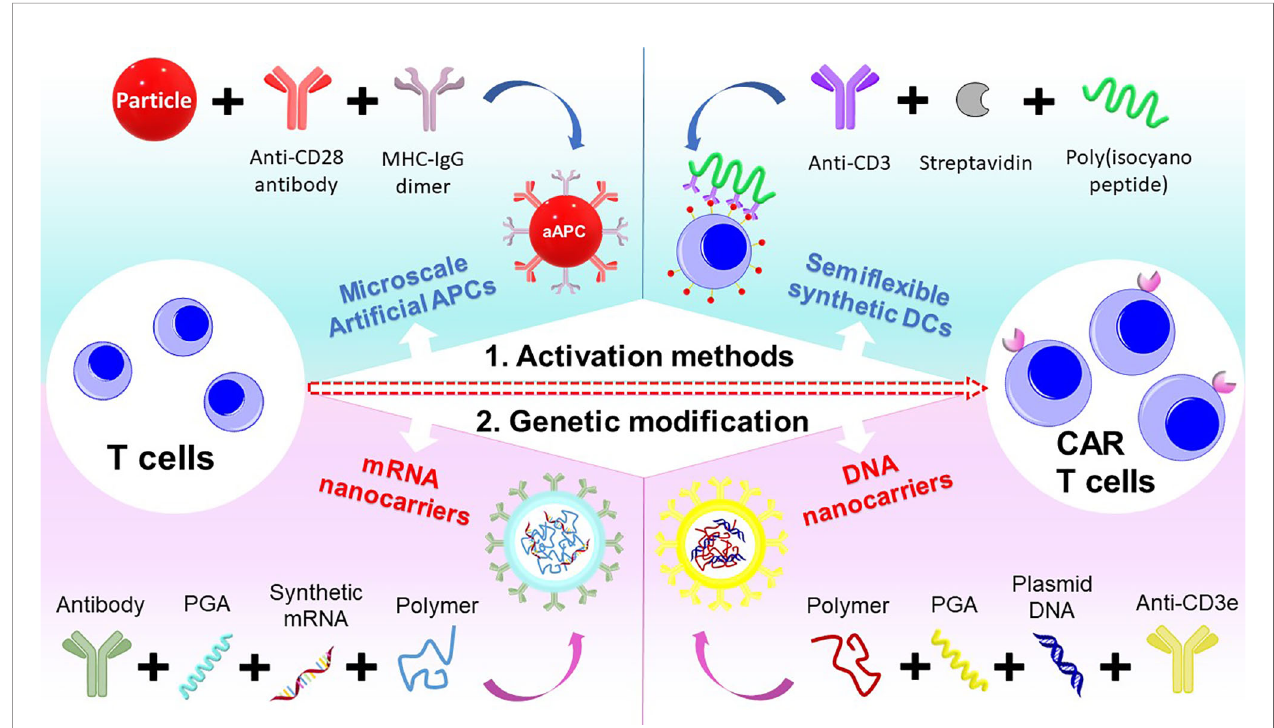
FIGURE 3 | Schematic of different polymeric systems designed for CAR-T cell